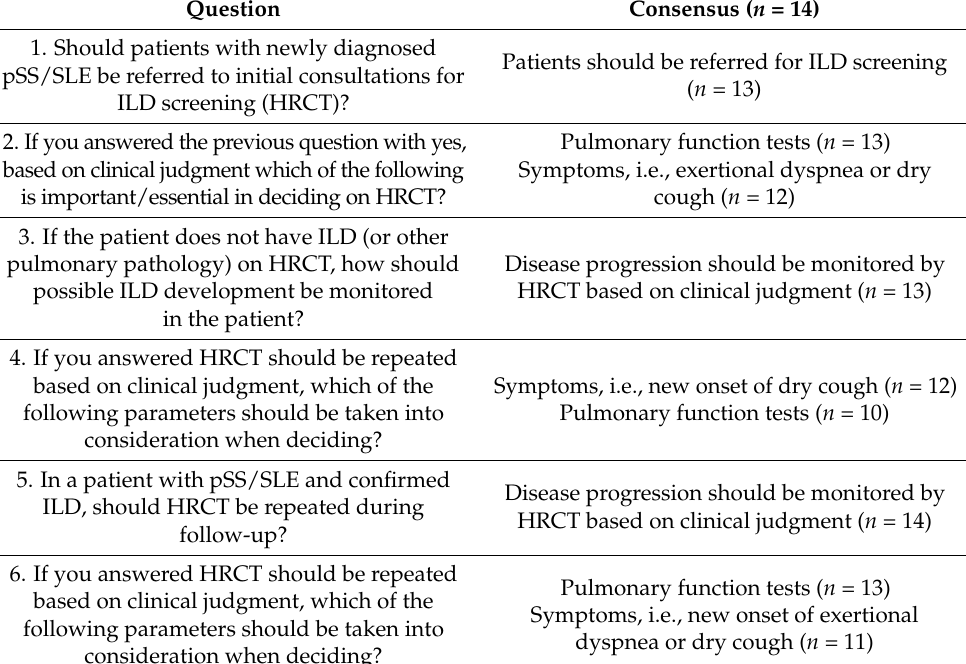
Table 2. Consensus results of the pSS and SLE questionnaire for screening and monitoring ILD. Question Consensus ( n = 14)